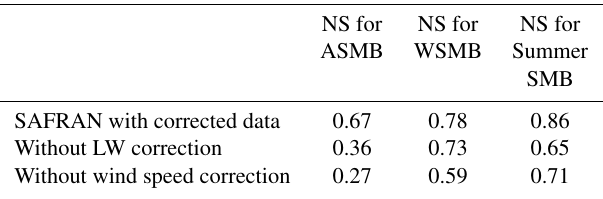
Table 4. NS efficiency coefficients for simulated surface mass bal- ances with respect to measured values over the 2006–2010 period. Simulations were performed with and without correction of the me- teorological forcing from